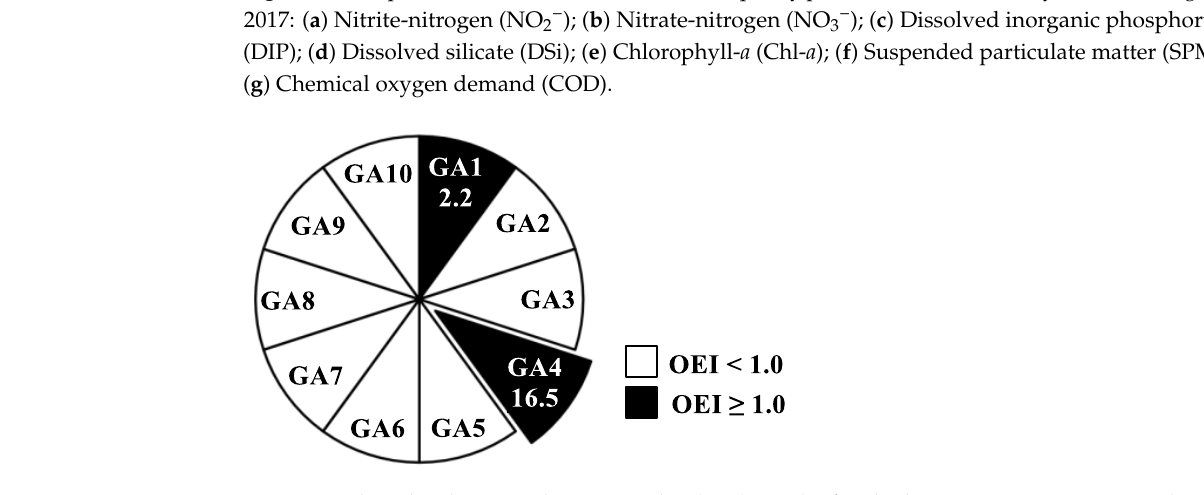
Figure 5. The Okaichi eutrophication index (OEI) results for the bottom seawater in Gamak Bay, Korea, in August 2017.